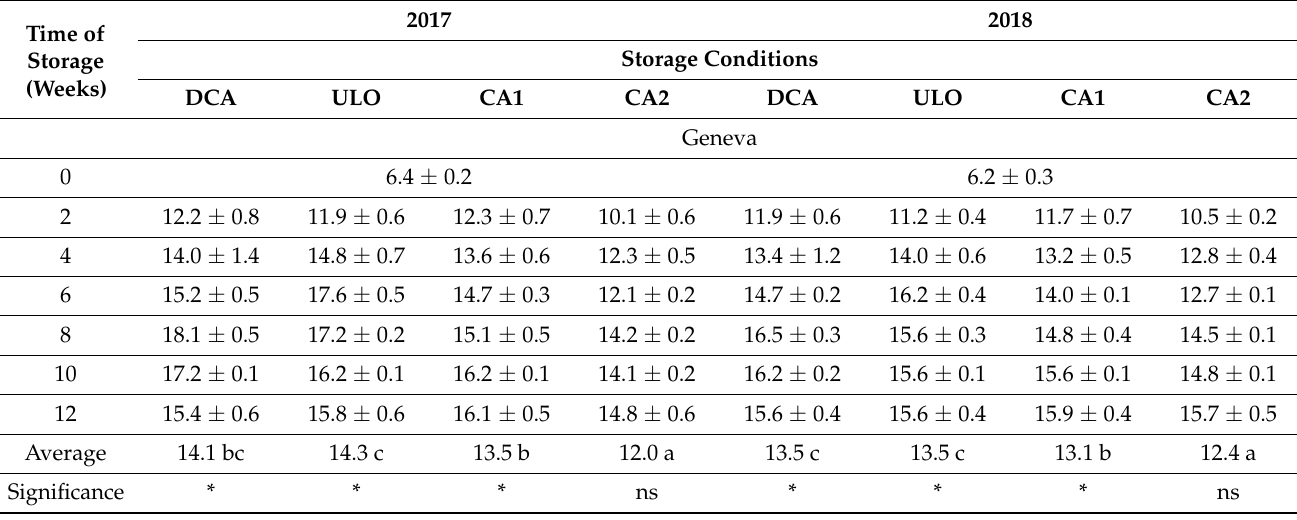
Table 2. Changes in total soluble solids content ( ◦ Brix) measured in ‘Geneva’ and ‘Ananasnaya’ minikiwi fruit in the postharvest